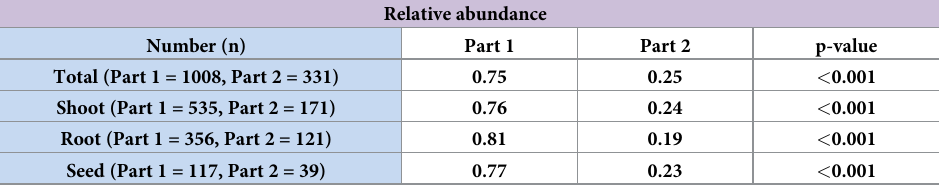
The fungi were collected from different tissues of switchgrass grown from different locations (part 1 or part 2) on a coal-mining site. The p-values were calculated using the function cor.test of R statistical